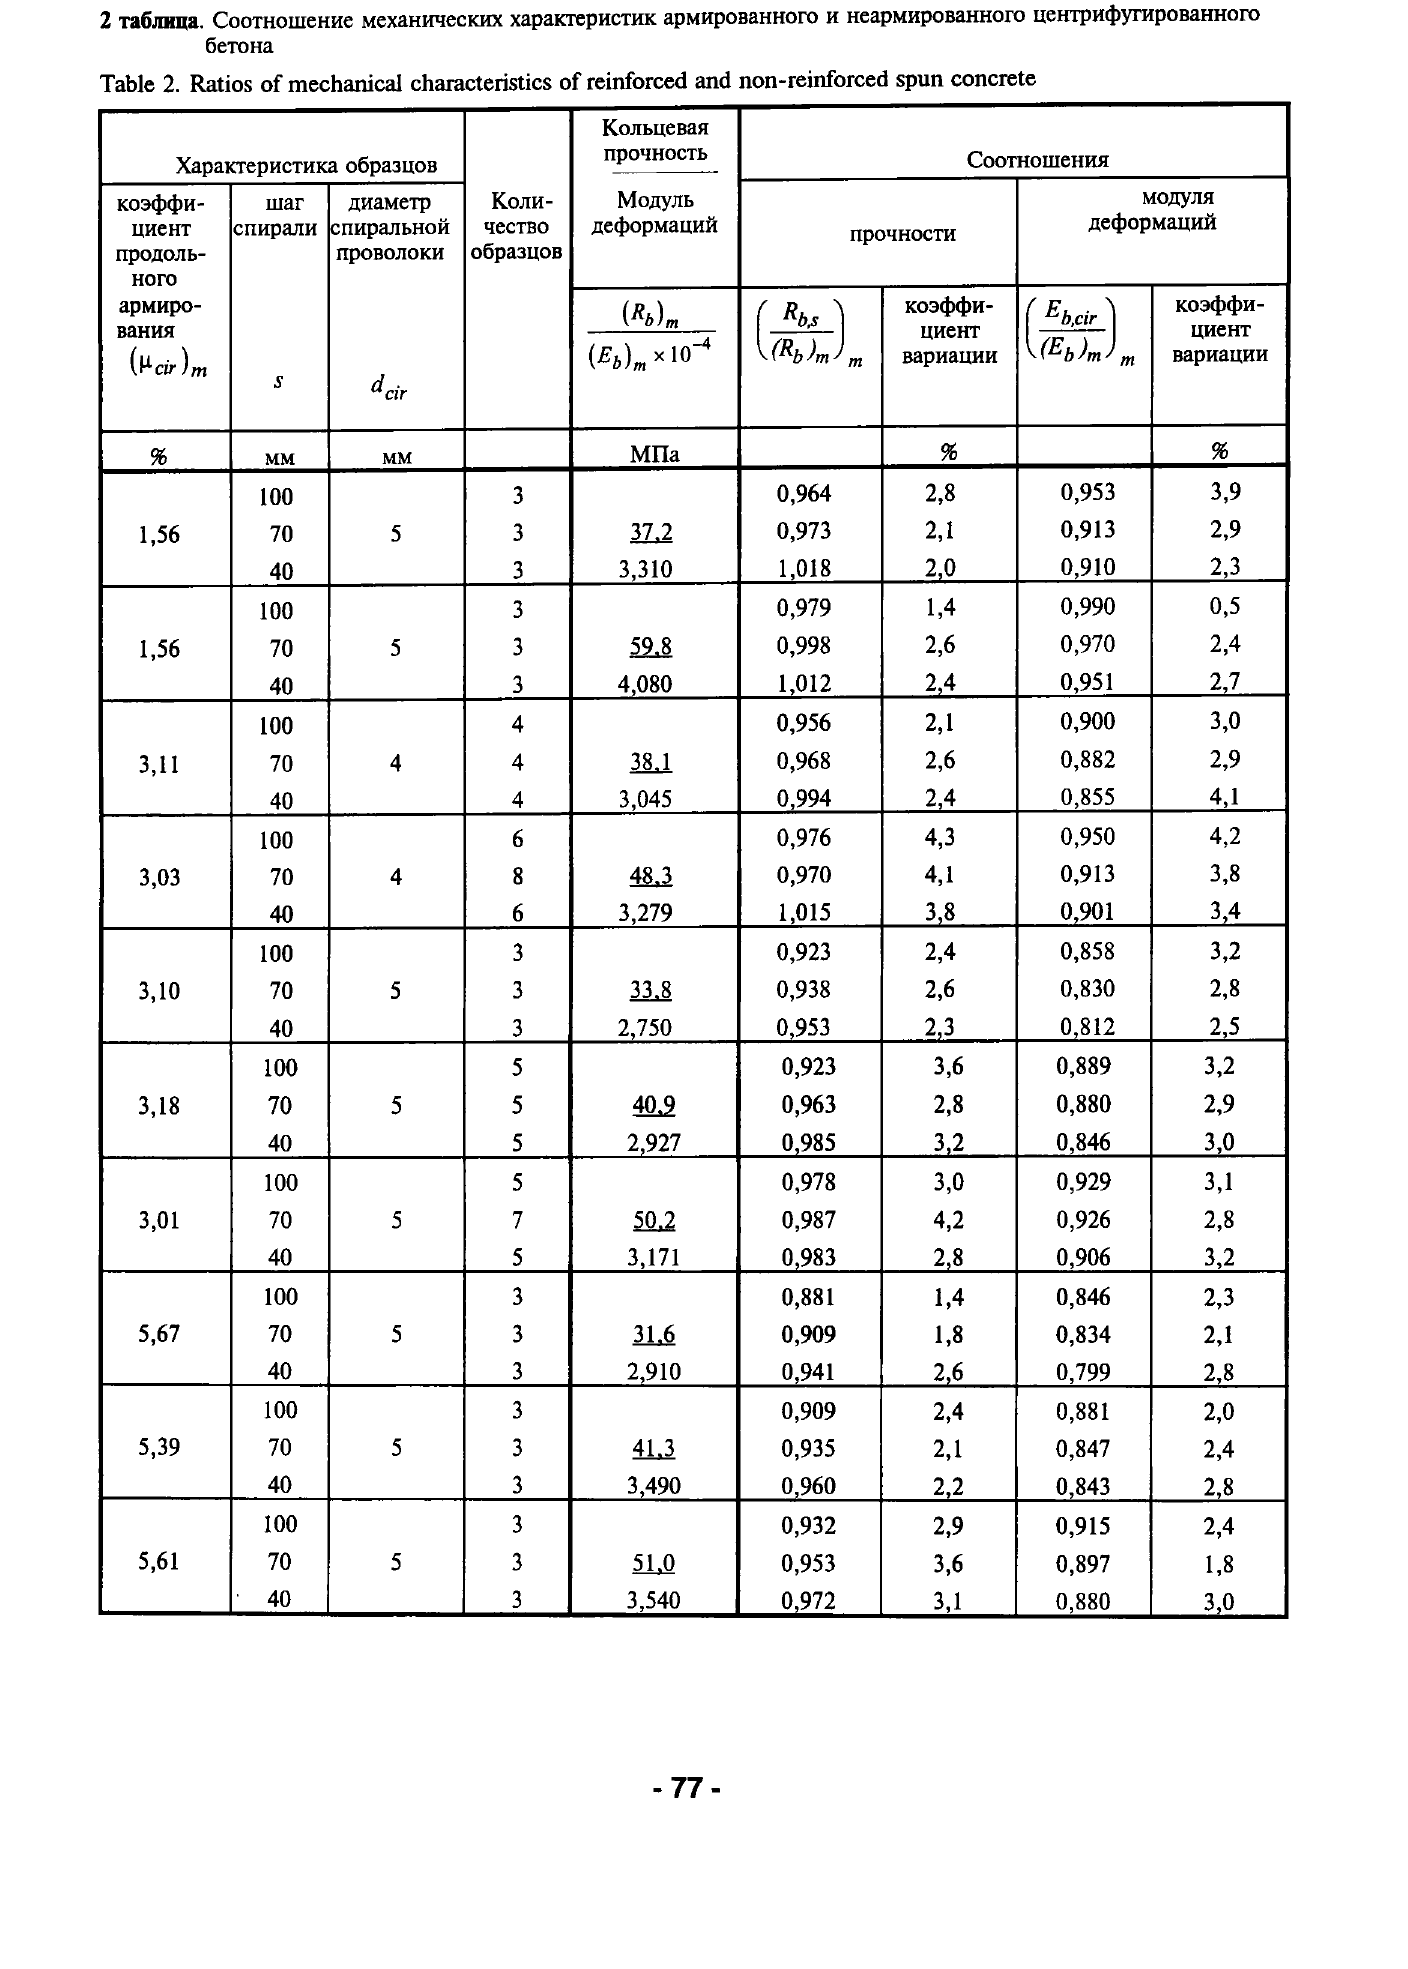
Table 2. Ratios of mechanical characteristics of reinforced and non-reinforced spun